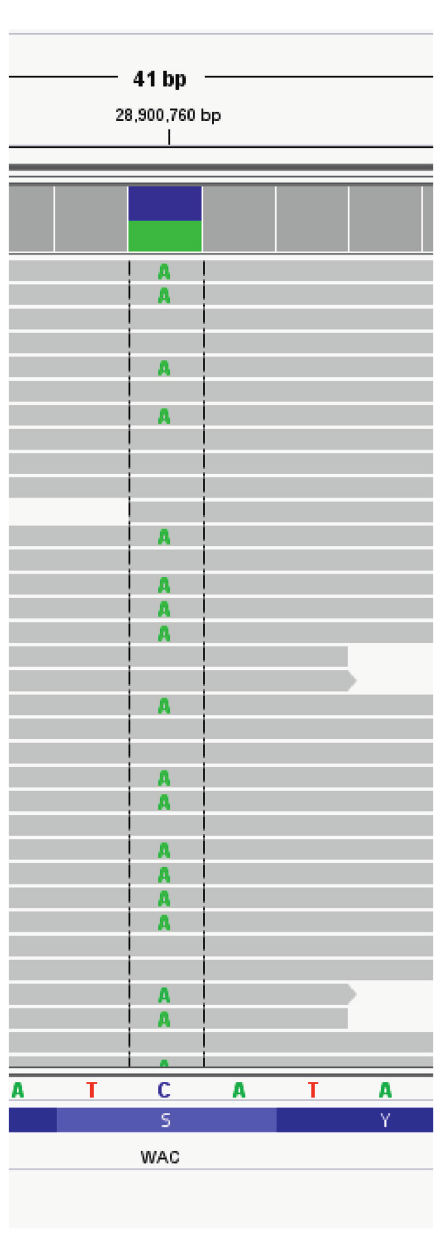
Figure 4: WAC mutation analysis showing 1346C >